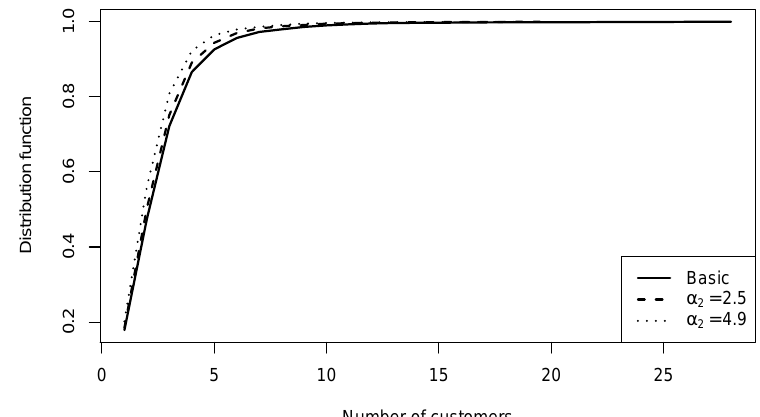
Figure 7. Stochastic monotonicity of the system output, in terms of steady-state queue size d.f., on the parameter α 2 = 2.1,2.5,4.9 of the mixture distribution in an M / G / c system with c = 4, λ = 2.2, mixture, F M of Pareto ( 2.1,1 ) and Pareto ( α 2 ,1 ) service time d.f. with mixing coefficient p = 0.7.